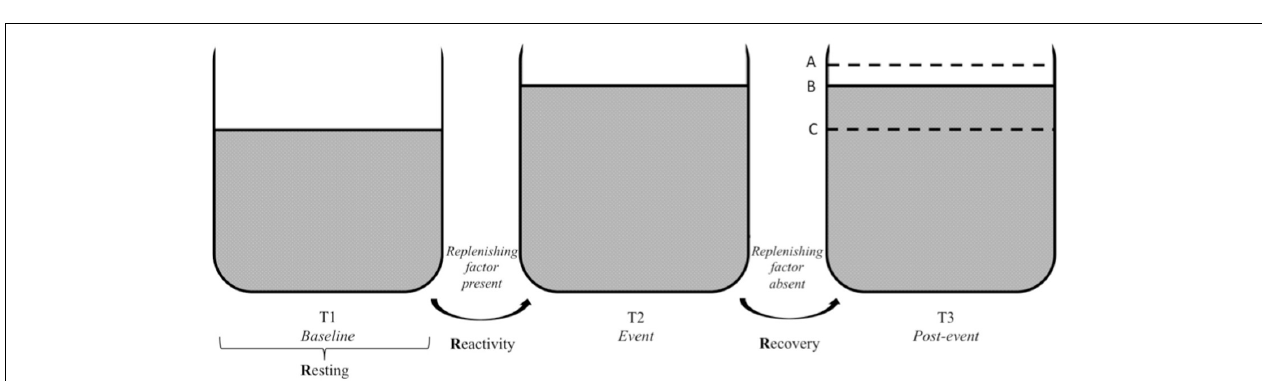
FIGURE 4 | Vagal tank and the 3 Rs of cardiac vagal control: effect of a replenishing factor. Illustration of the vagal tank and the three Rs (resting, reactivity, and recovery) with a factor replenishing cardiac vagal control. In regards to the post-event: A – displays a situation where the level of cardiac vagal control during the post-event is higher than the level during the baseline, B – displays a situation where the level of cardiac vagal control at post-event is similar to the event level, and C – displays a situation where the level of cardiac vagal control at post-event returned to baseline